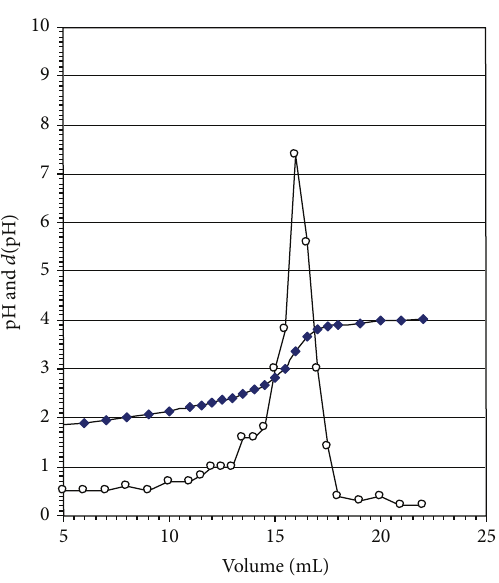
Figure 5: Potentiometric titration of 1mL of the acidified target solution after nitrite destruction diluted to 100mL with 0.100 N